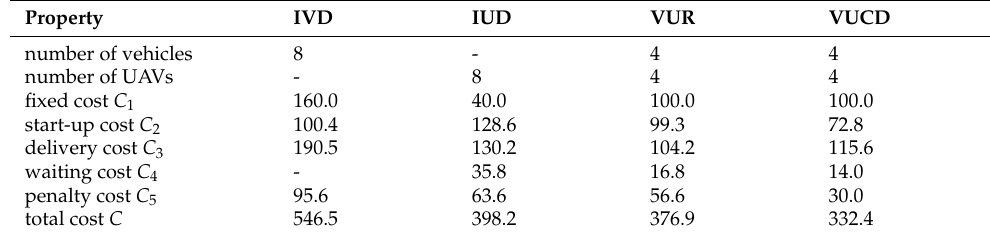
Table 4. Comparison of the results of different distribution